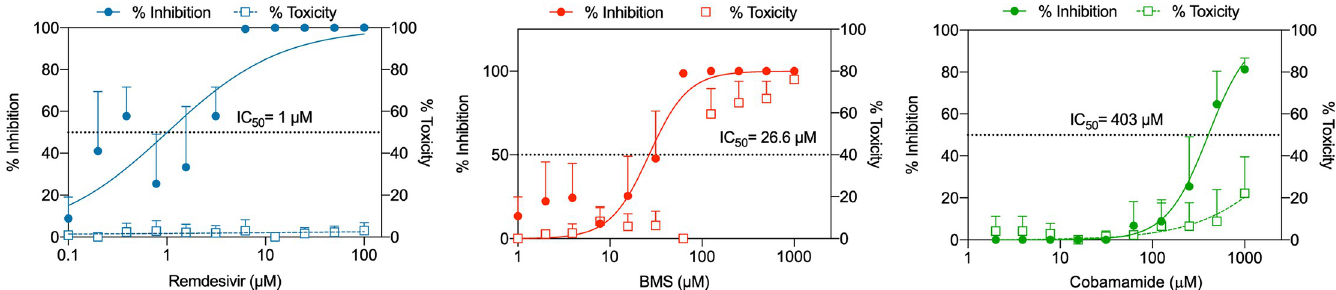
Fig 2. Dose-response inhibition of SARS-CoV-2 replication and cytotoxicity in Vero E6 cells. Vero E6 cells were treated with RDV, BMS or cobamamide at different concentrations for 2 h, followed by the addition of SARS-CoV-2 (MOI 0.05). After 1 h, cells were washed and cultured in compound-containing medium for 48 h. Virus production in the culture supernatants was quantified by plaque assay using Vero E6 cells. Cytotoxicity was measured in similarly treated but uninfected cultures via MTT assay. Data are mean ± s.d.; n =